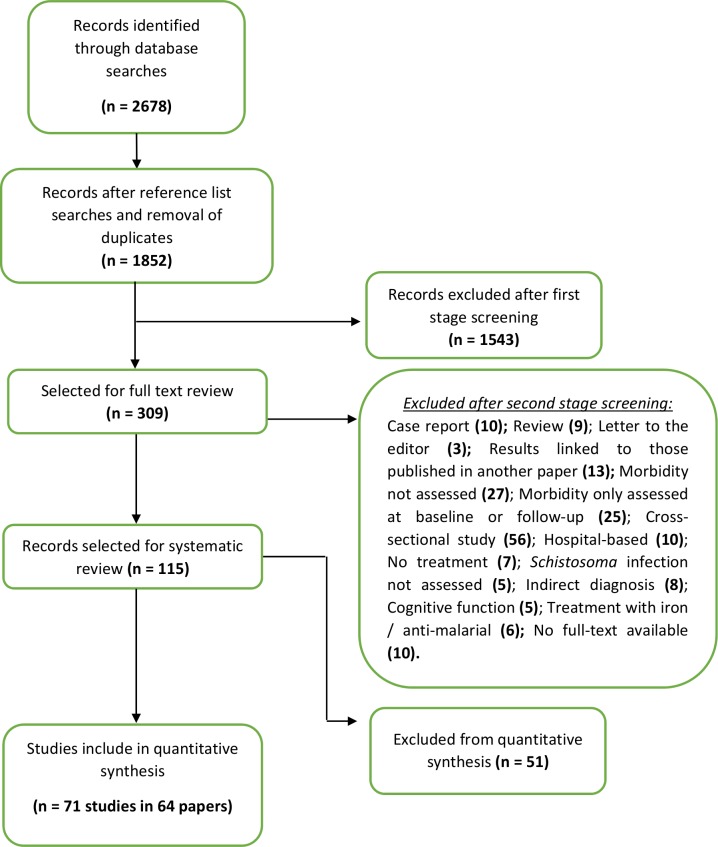
Flow chart of study search and selection strategy.The flow diagram indicates the numbers of titles and studies reviewed in preparation of the current systematic review and meta-analysis of chemotherapy treatment effects on infection-related morbidities in Schistosoma-endemic areas.